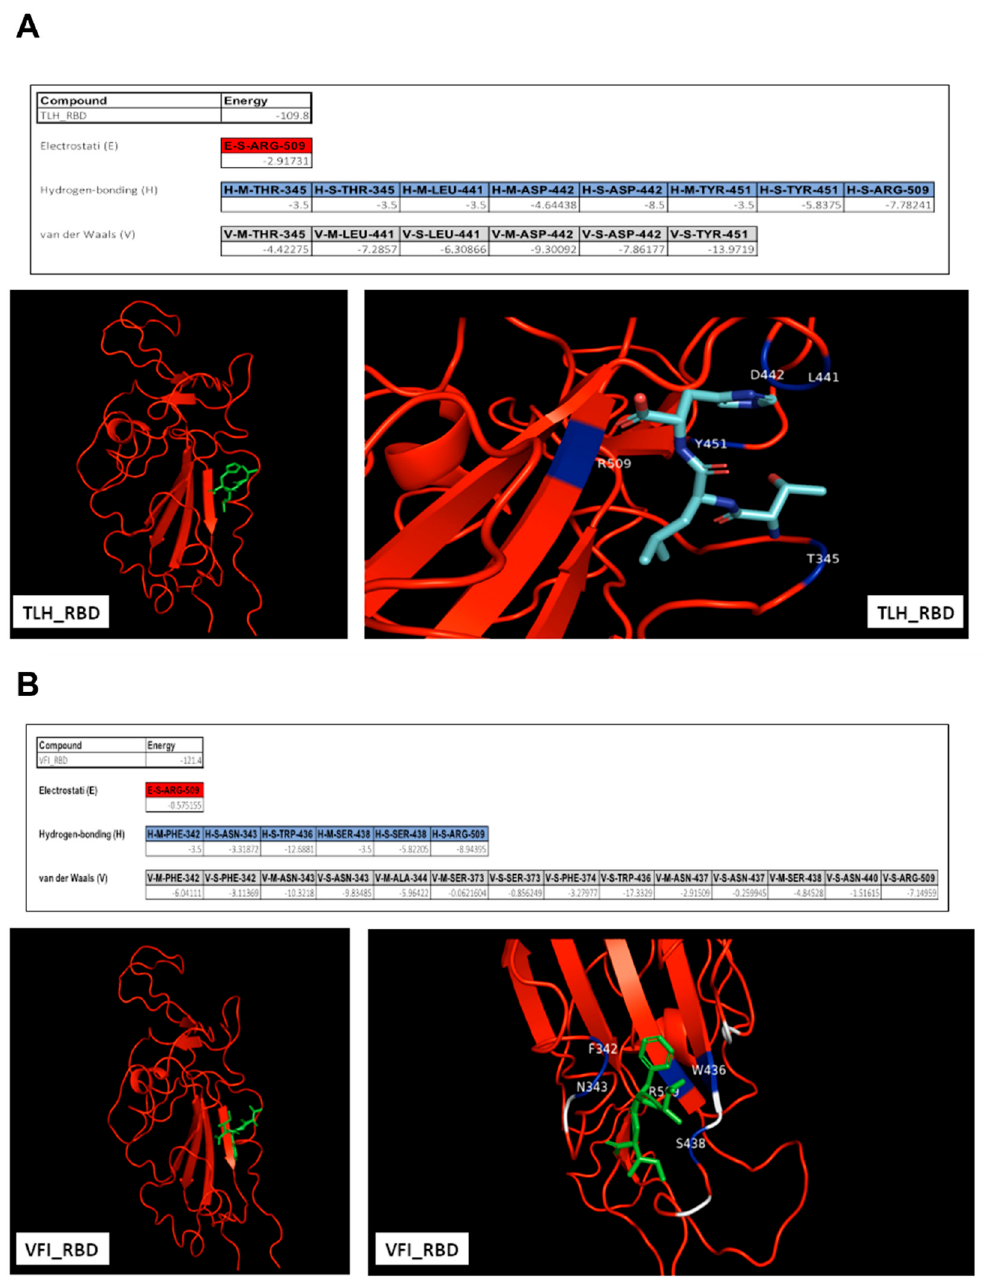
Figure 5. Interacting amino acids at the interface of SARS-CoV-2 RBD (PDB 6LZG). ( A ) TLH; ( B ) VFI. Electrostatic interactions, hydrogen bonds and van der Waals forces are indicated as E, H and V, respectively.